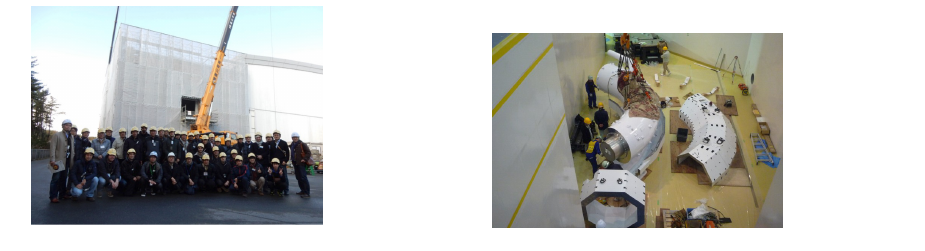
Figure 2. The COMET collaboration in front of the COMET building in January 2015.